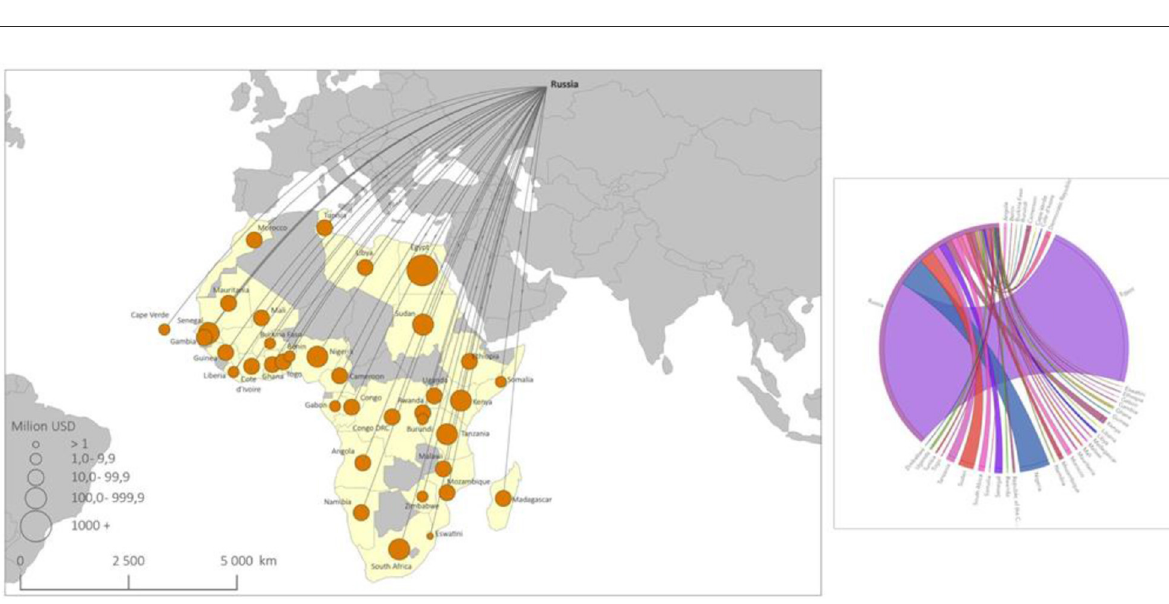
FIGURE4 Top 25 Russian wheat importing countries 2020. Source: Authors based on OEC data,